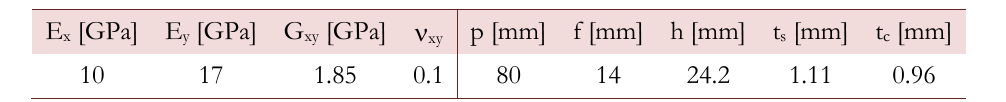
Table 1: Elastic properties of the laminate and geometric parameters of the sandwich.